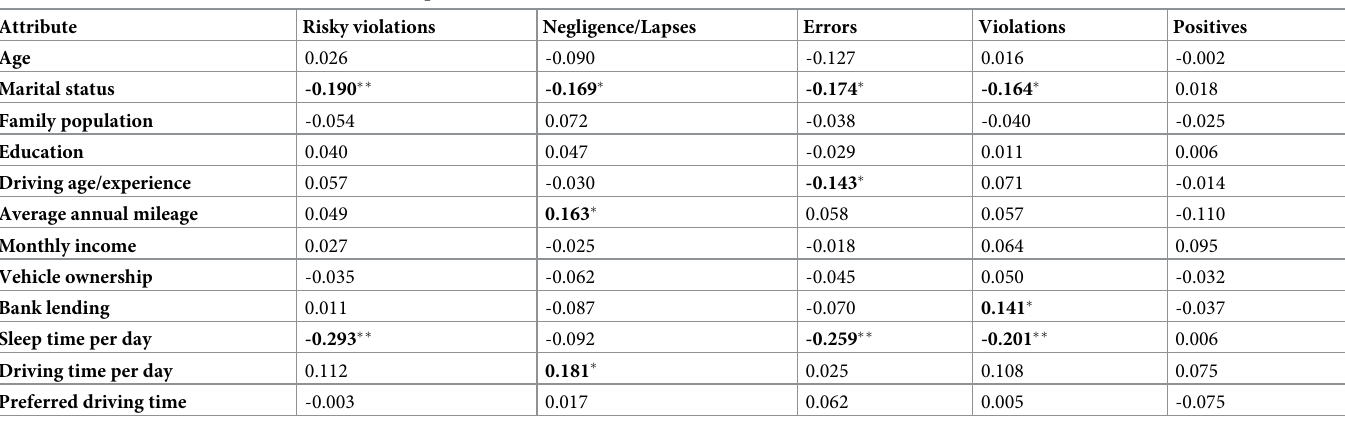
Table 4. Correlation matrix between factors of the questionnaire and total score.